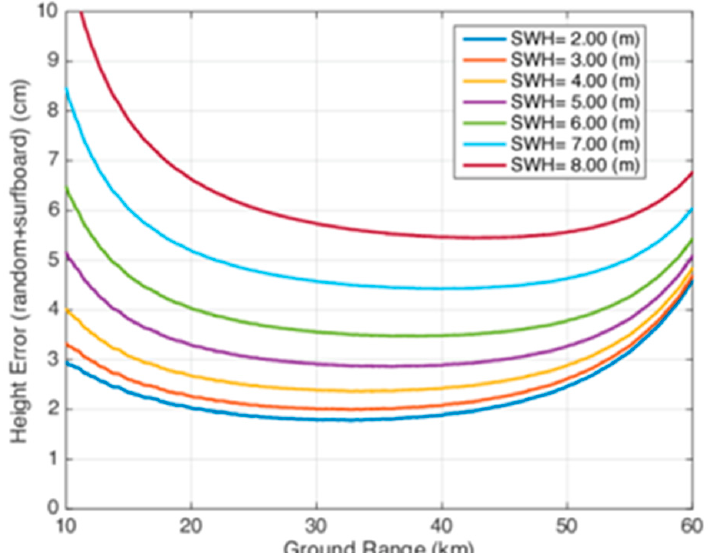
Figure 1. Height error (cm) of the KaRIn noise as a function of cross-track distance (km) from the nadir and the SWH (extracted from the documentation of the SWOT simulator). The KaRIn noise is more important at the borders of the swath and increases with the SWH. Thus, it varies geographically and temporally. These properties impact the performance of the classical smoothing.